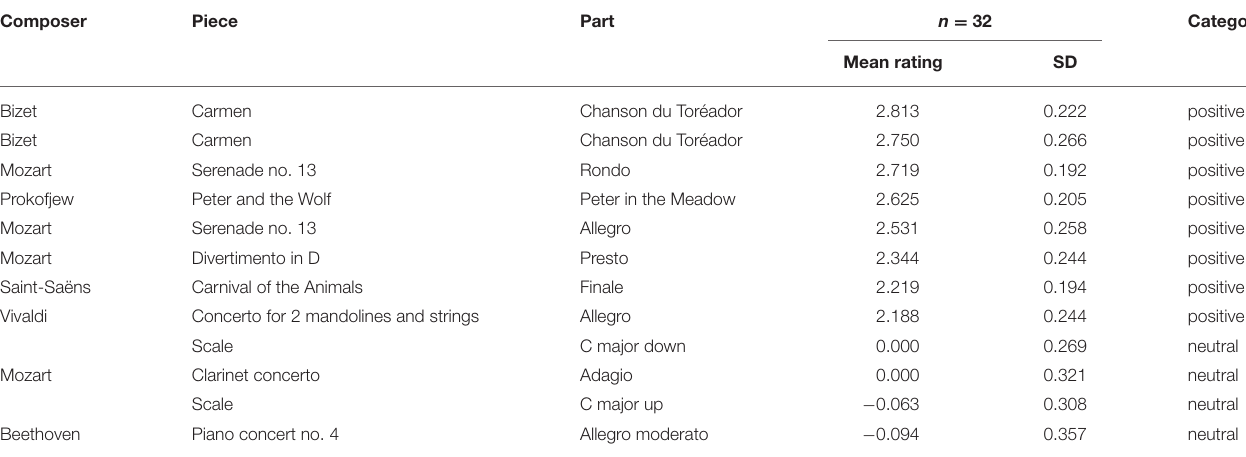
TABLE 1 | Pre-evaluation of auditory stimuli for the fMRI task. Composer